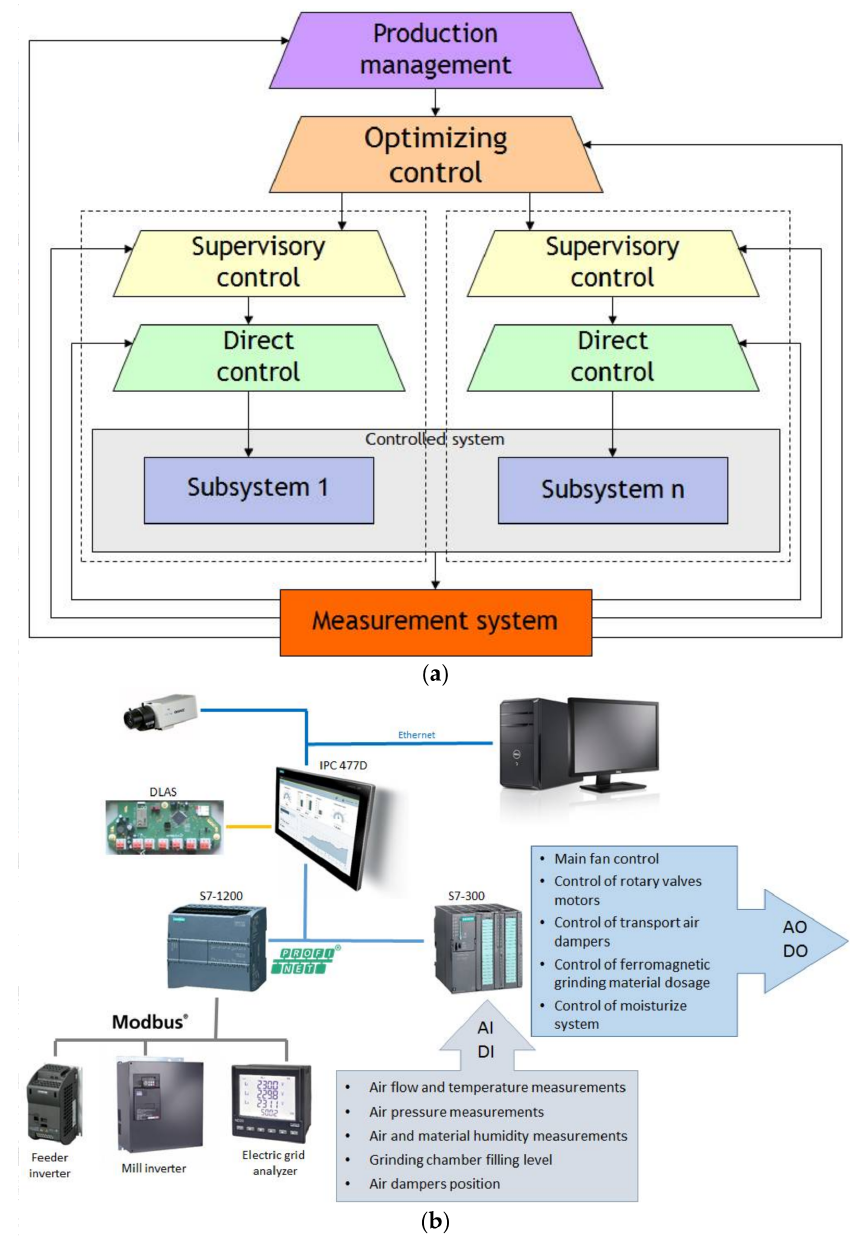
Figure 12. General structure of the multilayered control system for the electromagnetic mill installation: ( a )—hierarchy of the objectives; and, ( b )—hardware of the control